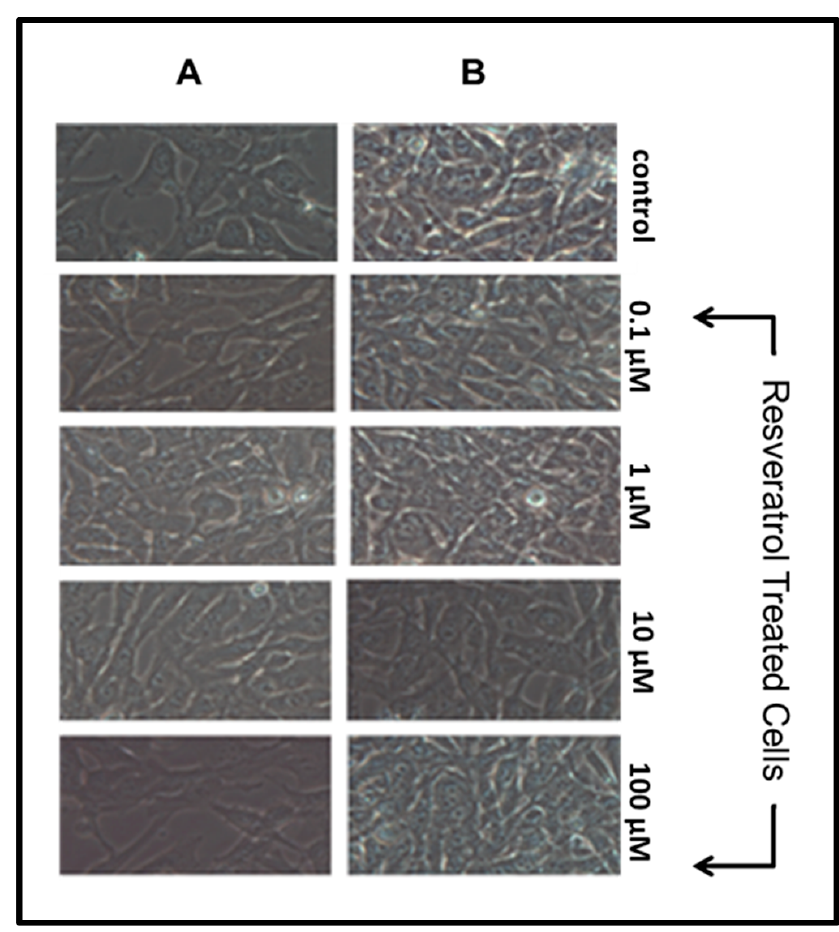
Figure 1. GTM-3 cells prior to treatment conditions ( A ) and 24 h after treatment ( B ) ( n = 3).